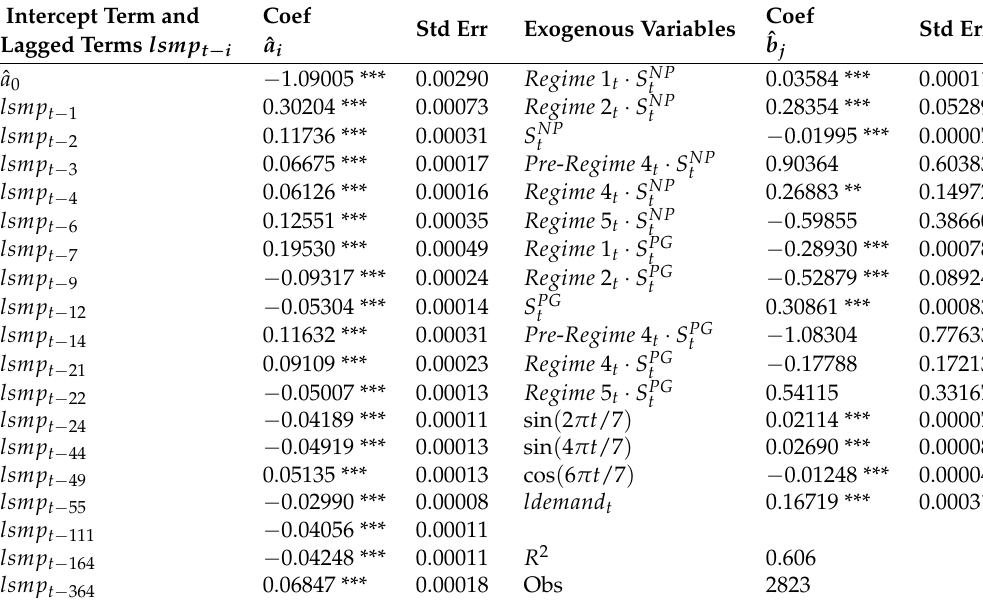
P ∑ a i lsmp t i + w (cid:48) t · b + ε t . − i = 1